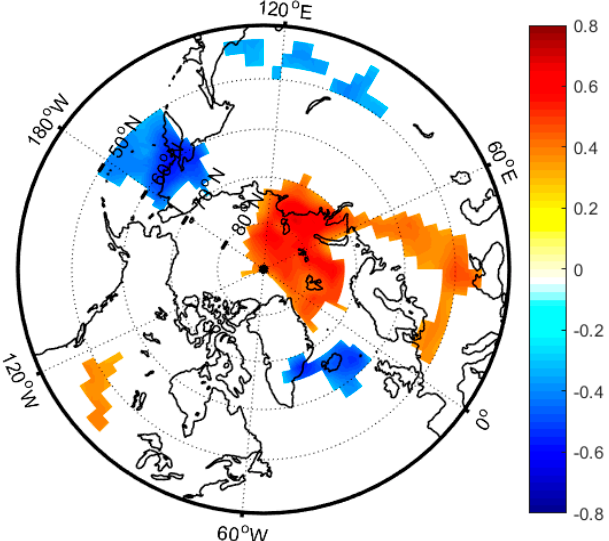
Figure 8. The correlation coefficient between the meridional 850 hpa water vapor of BKS in winter and the winter air temperature at 2 m in the northern hemisphere. The colored regions passed the t test with a confidence level of 90%. All the data have been de-trended.